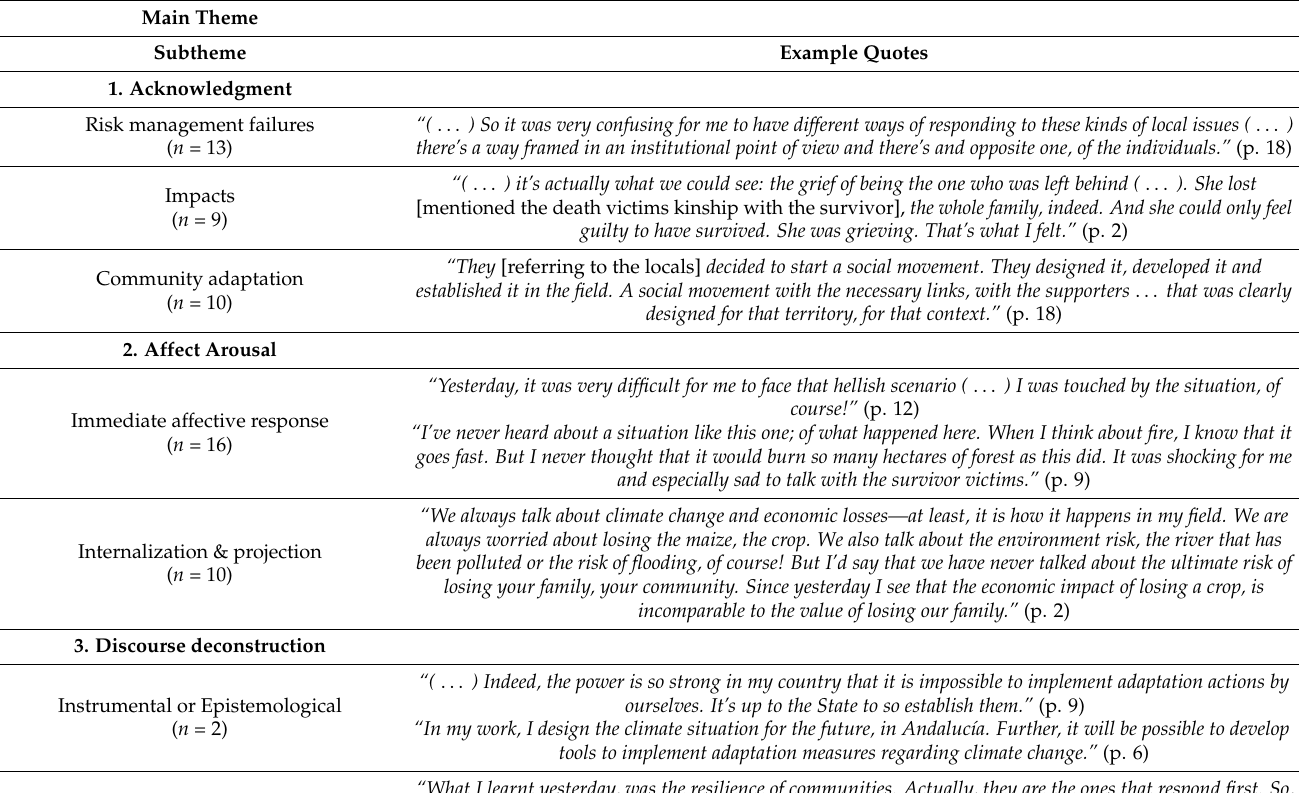
Table 2. Attitude change process after a post climate-hazard